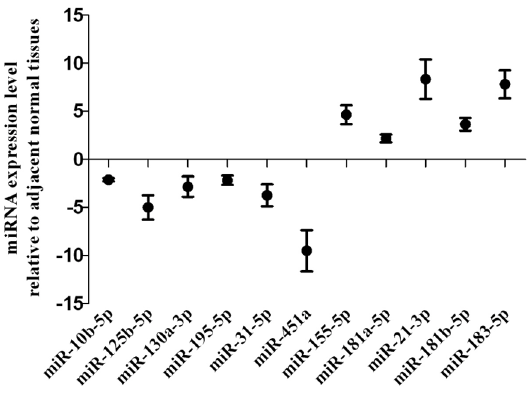
Figure 3. qRT-PCR validation of miRNAs microarray results in TNBCs. Relative expression of miRNAs in TNBCs compared with their adjacent normal tissues by qRT-PCR. miR-10b-5p, miR-451a, miR-125b- 5p, miR-31-5p, miR-195-5p, miR-130a-3p were down-regulated in cancer samples, whereas miR-155-5p, miR-21-3p, miR-181a-5p, miR- 181b-5p and miR-183-5p were up-regulated. Dots, normalized ratio of miRNA expression values (TNBC/adjacent normal tissues).